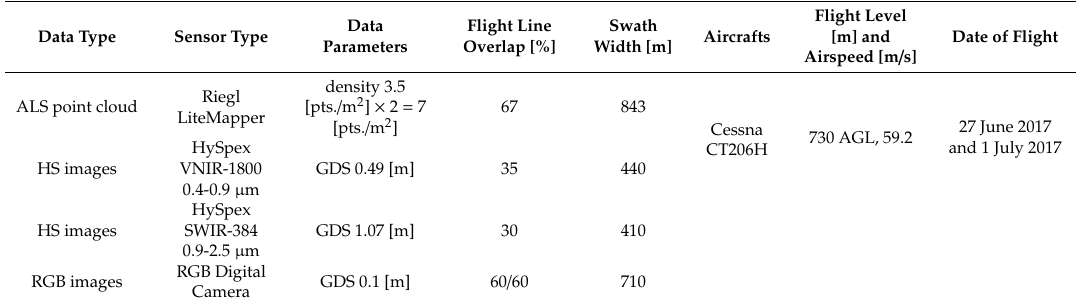
Table 2. Fusion of data collected with di ff erent sensors in a single flight, using the HabitARS platform. Abbreviations: HS—Hyperspectral; ALS—Aerial Laser Scanning; VNIR—Visual-Near Infrared; SWIR—Short Wave Infrared; RGB—Red Green Blue; GSD—Ground Sampling